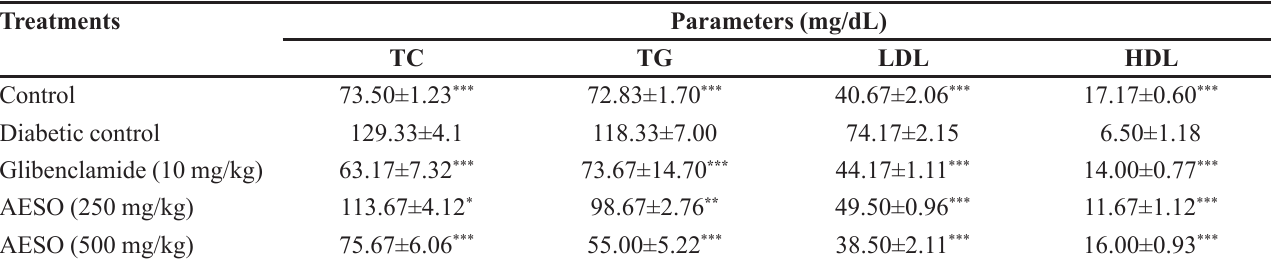
TABLE III - Effect of aqueous extract of Sigesbeckia orientalis on total cholesterol, triglycerides, low density lipoproteins and high density lipoprotein levels in different treatment groups Treatments